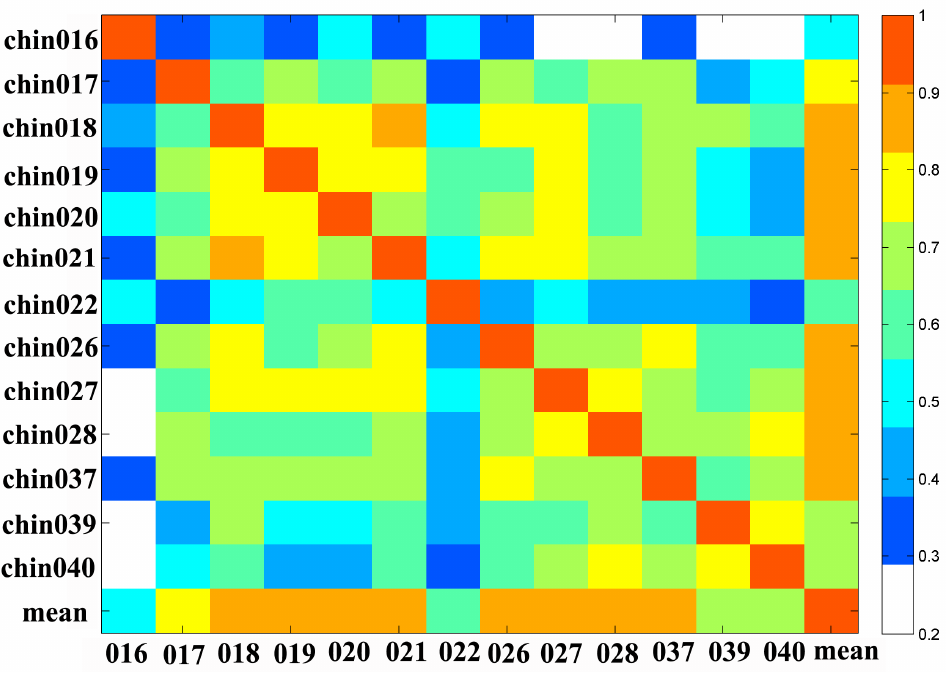
Figure 4. Correlation coefficients between the signal-free chronologies from 1911 to 2005. The white color indicates that the Pearson’s correlation was non-significant ( p > 0.05).